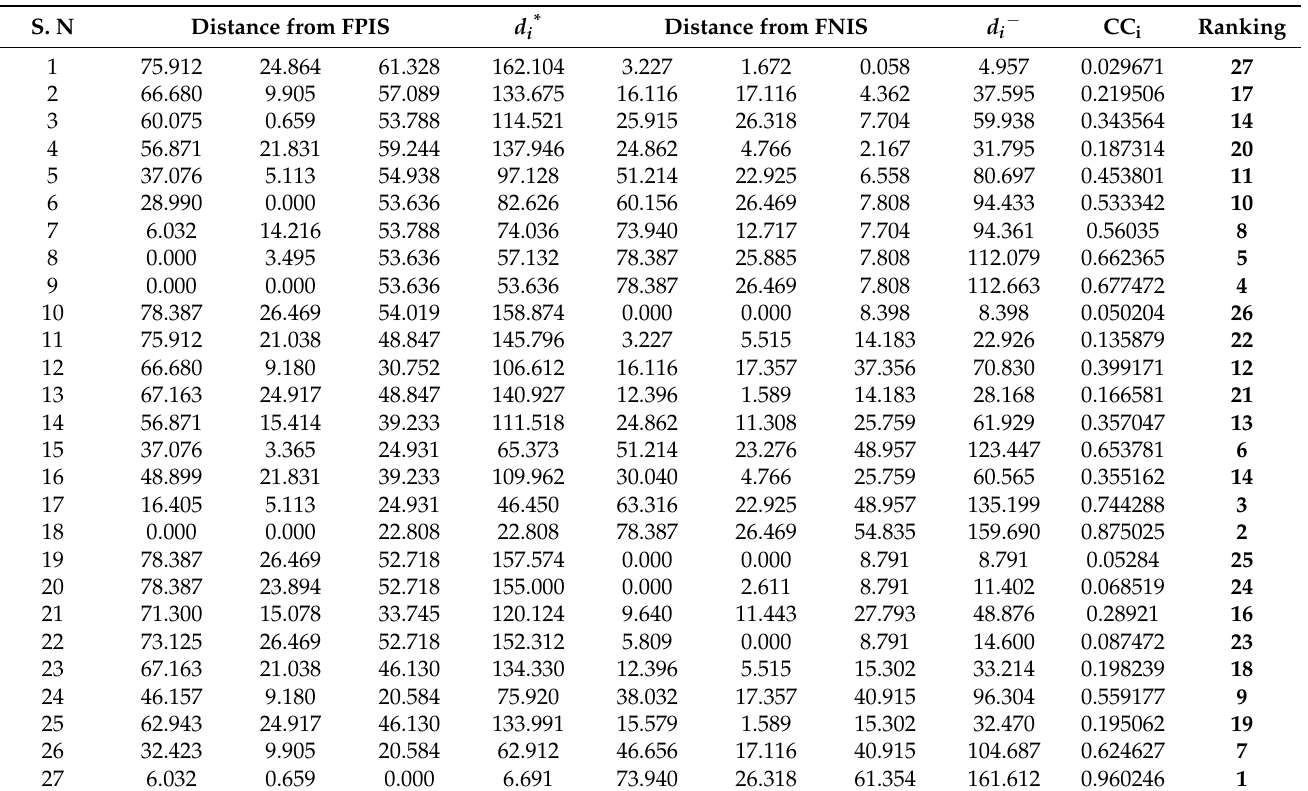
Table 9. Distance from a positive and negative ideal solution and ranks of the node